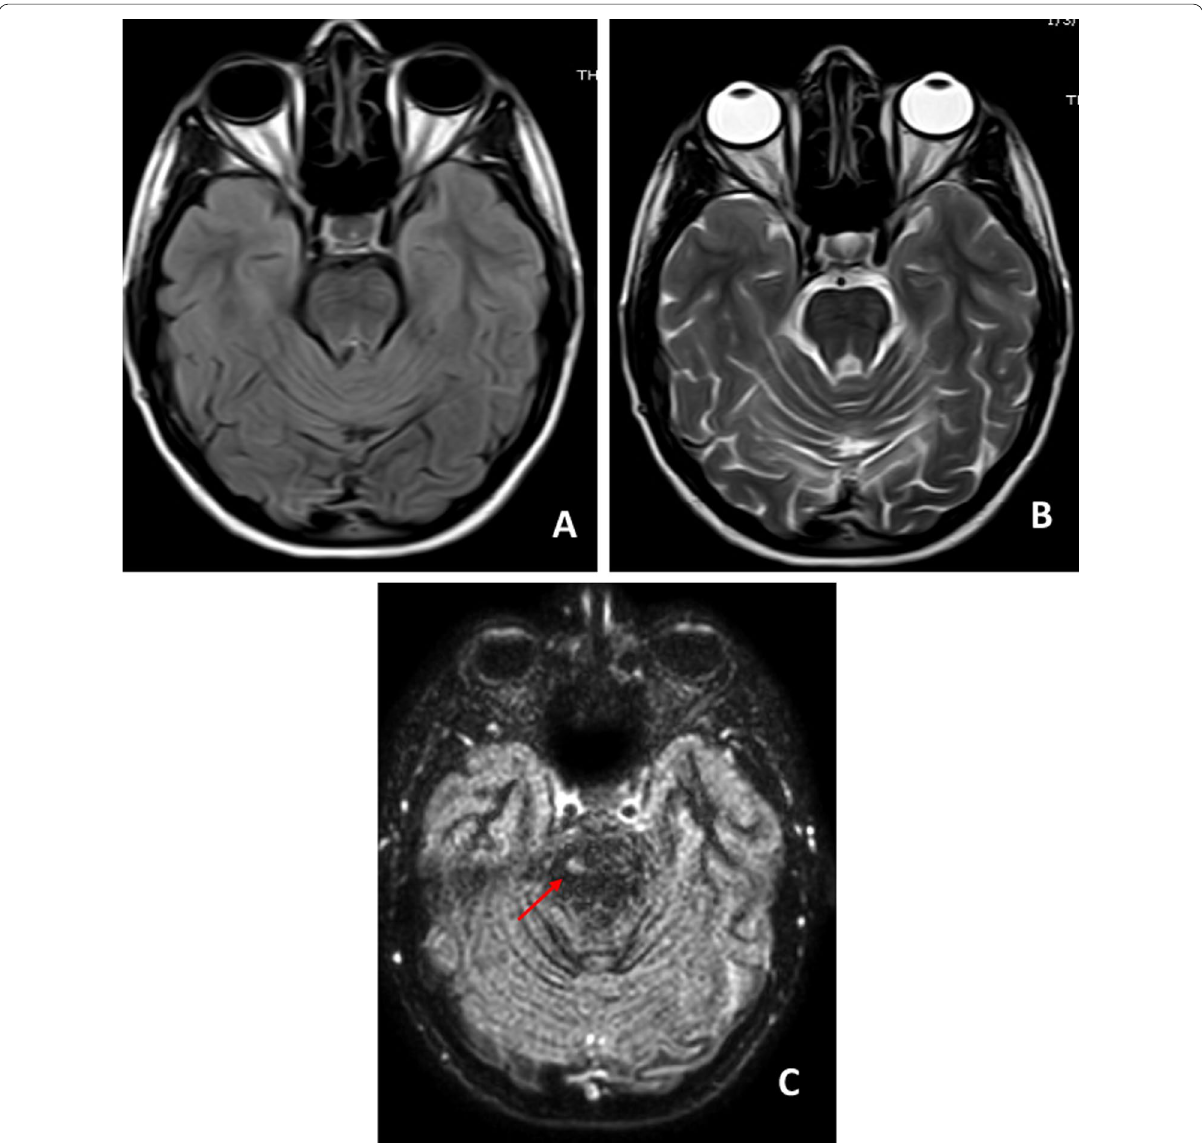
Fig. 6 A 21-year-old female patient with relapsing–remitting MS and EDSS score of 1.5. No evidence of MS plaque in the axial FLAIR ( A ) and T2 WI ( B ). C Axial DIR at the same level clearly defines the pontine plaque (red